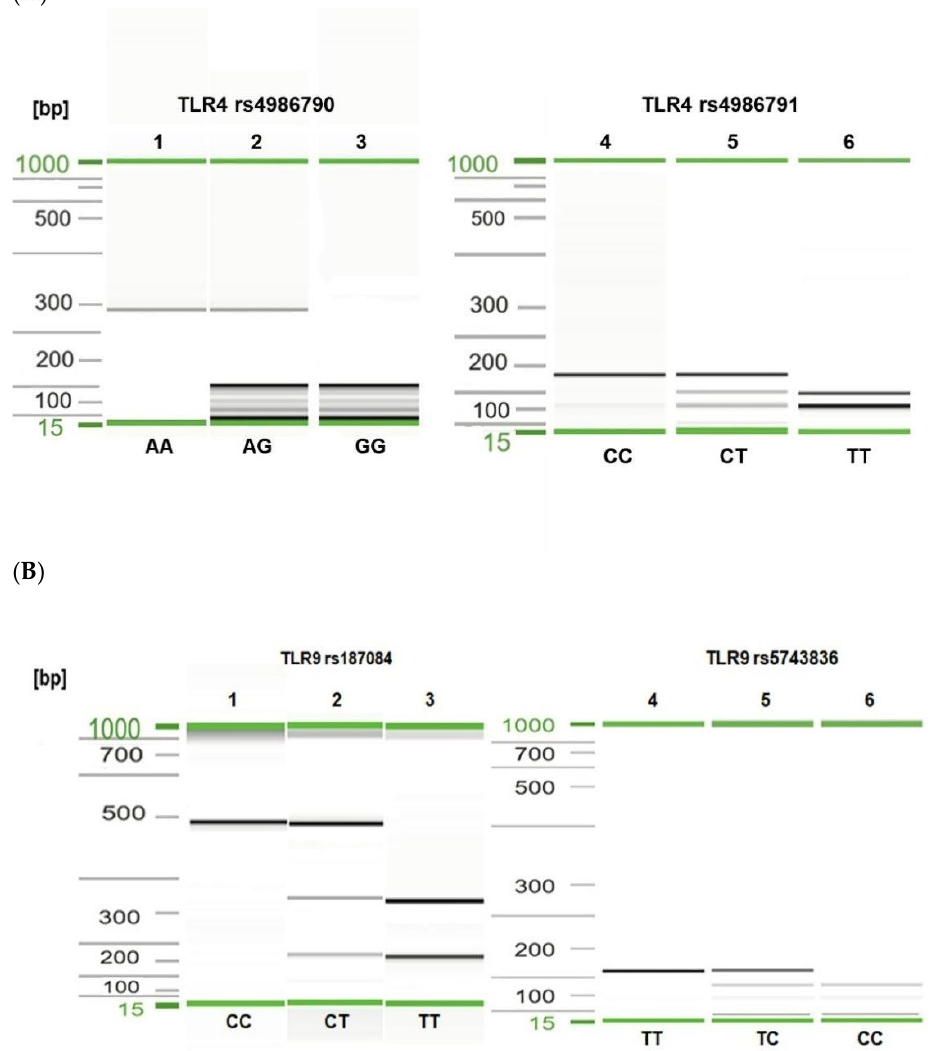
Figure 1. Visualization of selected PCR-RFLP products for TLR4 rs4986790, rs4986791 ( A ) and TLR9 rs187084, rs5743836 ( B ) genotyping. Gel image: ( A ), TLR4 genotyping (1 – 3 — rs4986790); 1, AA gen- otype; 2, heterozygous AG genotype; 3, GG genotype; (4 – 6 — rs4986791); 4, CC genotype; 5, CT gen- otype; 6, TT genotype; ( B ), TLR9 genotyping (1 – 3 — rs187084); 1, CC genotype; 2, CT genotype; 3, TT genotype; (4 – 6 — rs5743836); 4, TT genotype; 5, TC genotype; 6, CC genotype. Alignment markers (15 bp, 1 kbp).